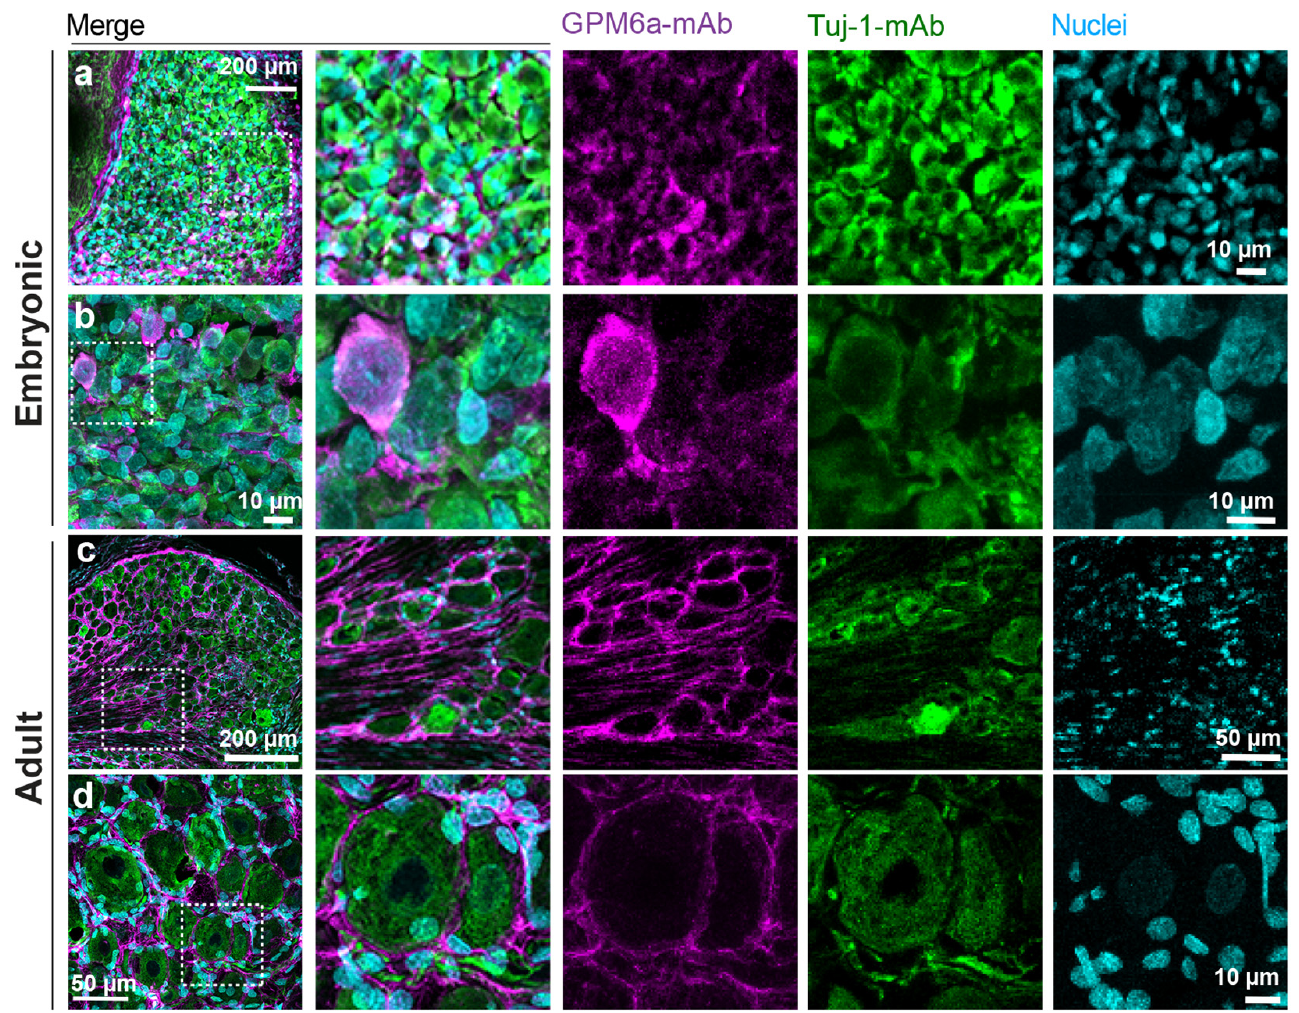
Figure 1. GPM6a was detected in both embryonic and adult rat DRGs. Representative images of embryonic ( a , b ) and adult ( c , d ) DRGs. N = 3 independent experiments with n = 5–8 DRGs per stage of development were analyzed. Intact DRGs were fixed, prepared for sectioning on a cryostat (at 20 µ m), and analyzed immunohistochemically. Images show positive immunostaining for GPM6a (GPM6a-mAb, shown in magenta) and β -tubulin III (Tuj-1-mAb, shown in green). Cell nuclei were imaged with methyl green (cyan). Confocal images were acquired with an Olympus FV1000 confocal microscope using the following settings: ( a ) Ten-times objective and 5 × digital zoom. Inset: 80 × 80 µ m. ( b ) Sixty-times objective and 2 × digital zoom. Inset: 25 × 25 µ m. ( c ) Ten-times objective and 2 × digital zoom. Inset: 200 × 200 µ m. ( d ) Sixty-times objective and no digital zoom. Inset: 65 × 65 µ m. Scale bars are indicated in the figure. Images are a maximal projection of 26 z-stacks and 0.5 µ m step size ( a ), 22 z-stacks and 0.25 µ m step size ( b ), 5 z-stacks and 0.25 µ m step size ( c ), and 19 z-stacks and 0.5 µ m step size ( d ).